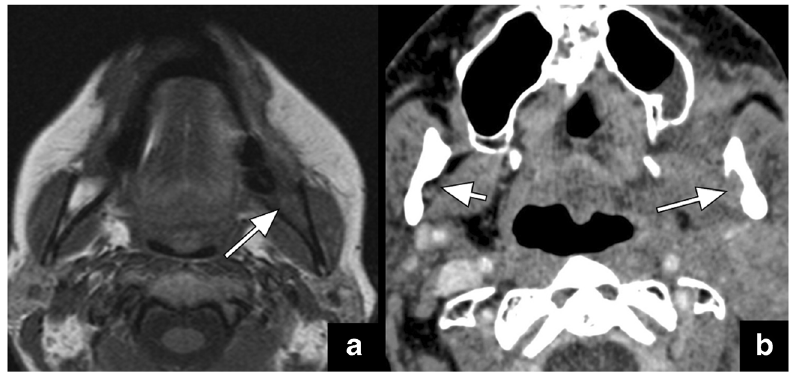
Fig. 6 Axial T1-weighted image ( a ) shows obliteration of the fatty bone marrow in the left mandible ( arrow in a ). The axial CT image ( b ) of the same patient reveals obliteration of the fat pad at the mandibular foramen ( long arrow in b ), compared to the normal fat pad on the right ( short arrow in b ). These signs are indicative of PTNS along V3 in this patient with history of gingival cancer and V3